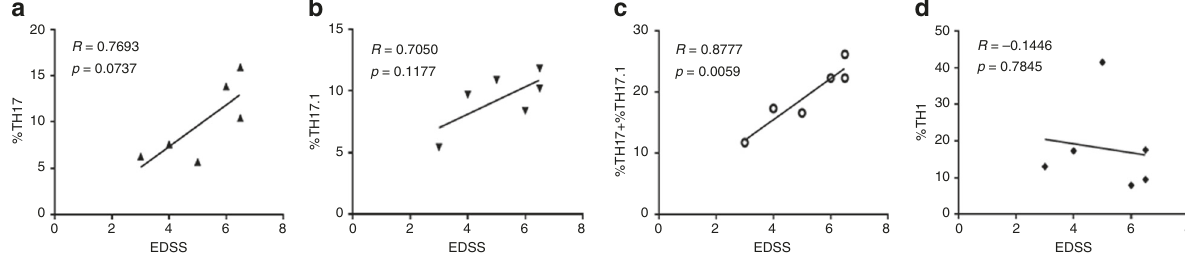
Fig. 2 Correlation between TH17 and disability in NMOSD patients. Correlations between EDSS and a %TH17, b %TH17.1, c %TH17 + %TH17.1, and d % TH1 cells in NMOSD patients ( n = 6). Two-tailed Pearson correlations were used to determine statistical signi fi cance. P values < 0.05 were considered signi fi cant and P values > 0.05 were not signi fi